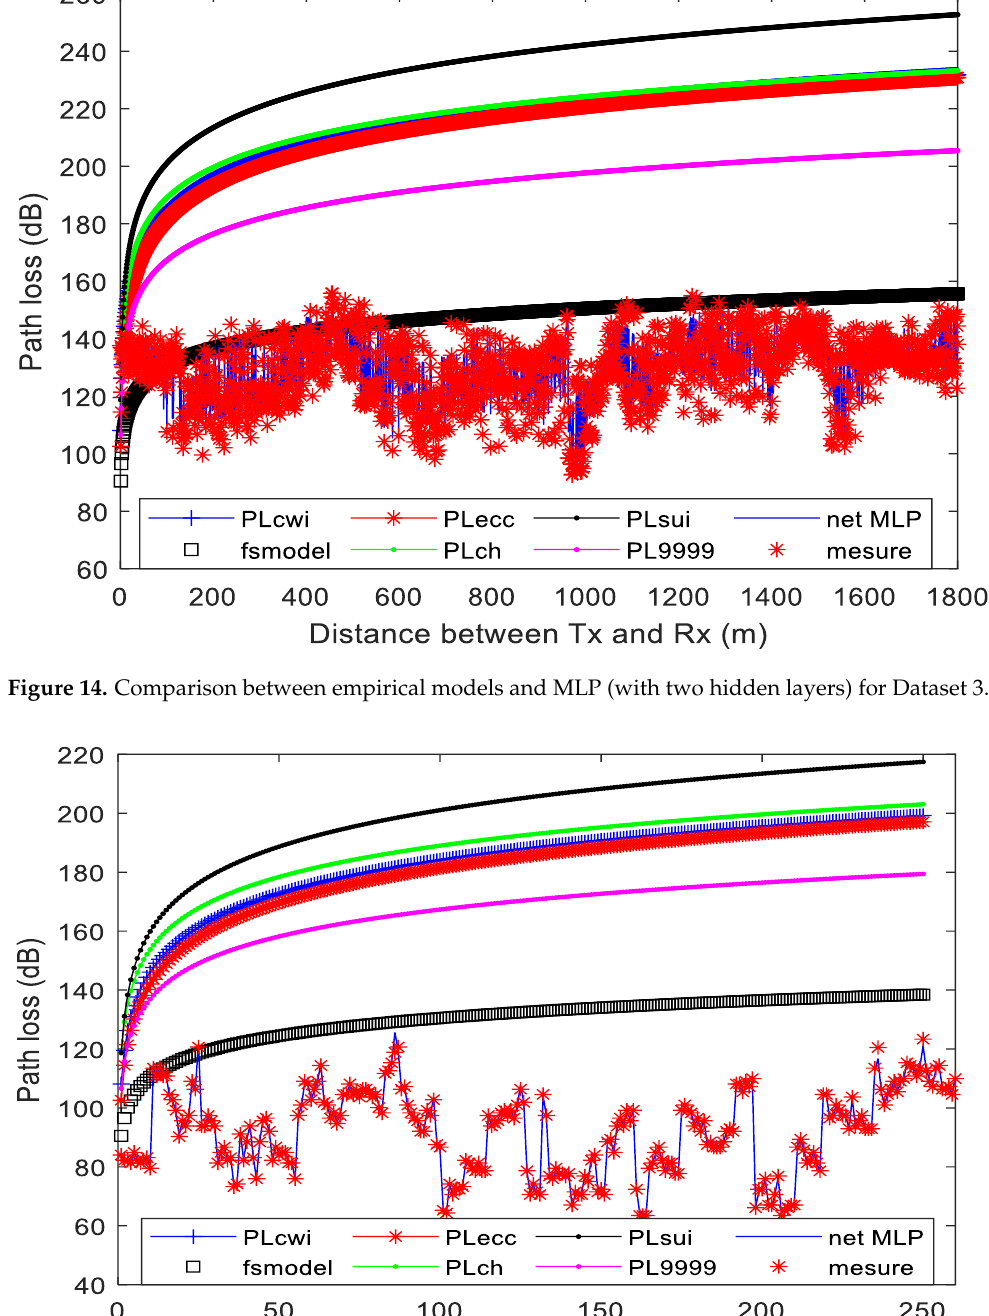
Figure 13. Comparison between empirical models and MLP (with one hidden layer) for Dataset 7.